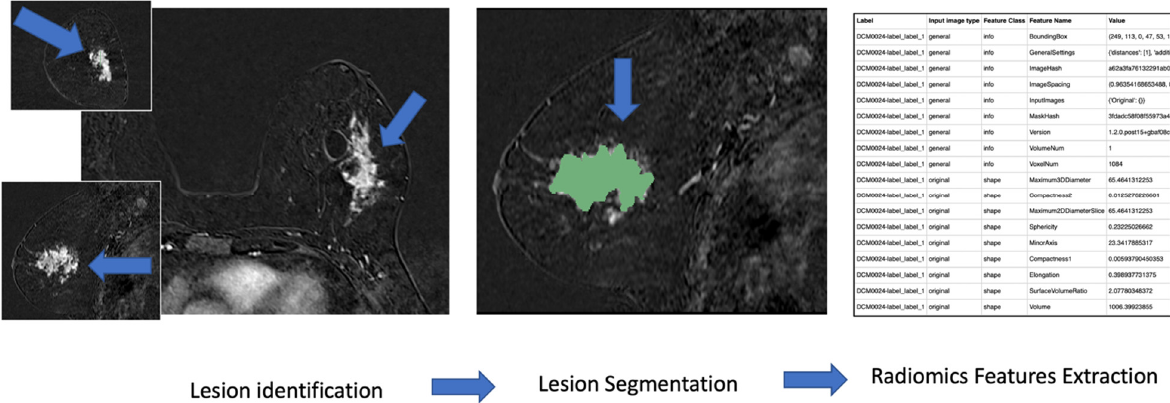
Figure 1. Workflow of image segmentation .